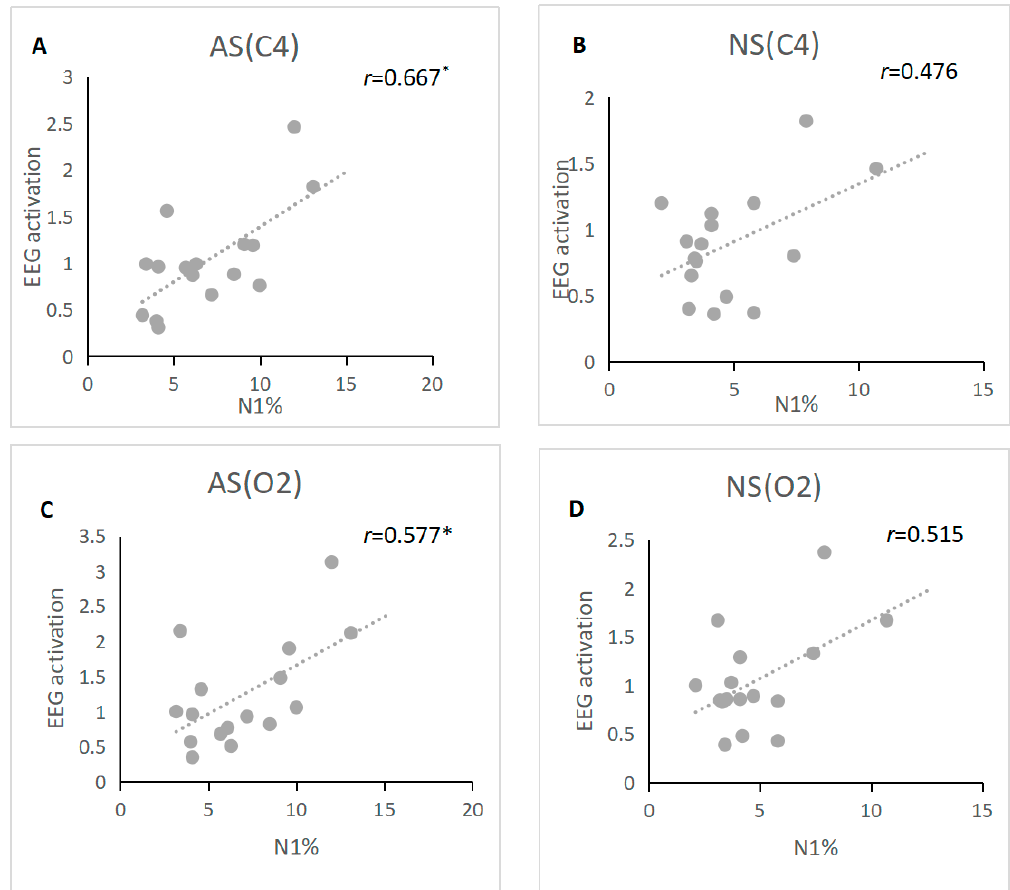
Figure 1. Association between the percentage of stage N1 and EEG activation during stage N2. Note: The relationship between the percentage of stage N1 and stage N2 EEG activation at the C4 electrode on Night 1 (shown in ( A )) and Night 2 (shown in ( B )). The relationship between the percentage of stage N1 and stage N2 EEG activation at the O2 electrode on Night 1 (shown in ( C )) and Night 2 (shown in ( D )). The p -values were corrected for multiple comparisons; * p < 0.05.